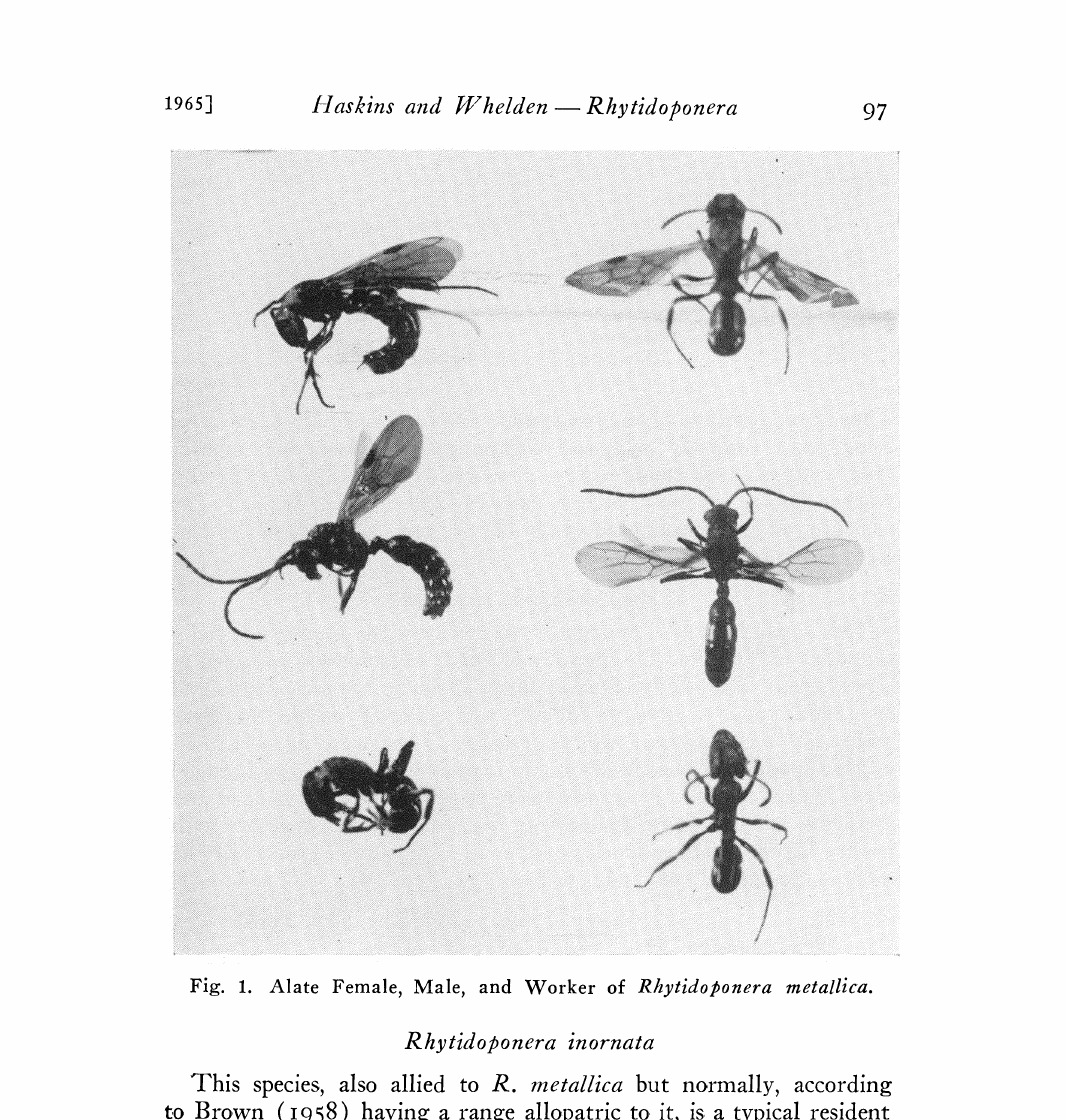
Fig. 1. Alate Female, Male, and Worker of Rhytido#onera metallica. Rhytidoponera